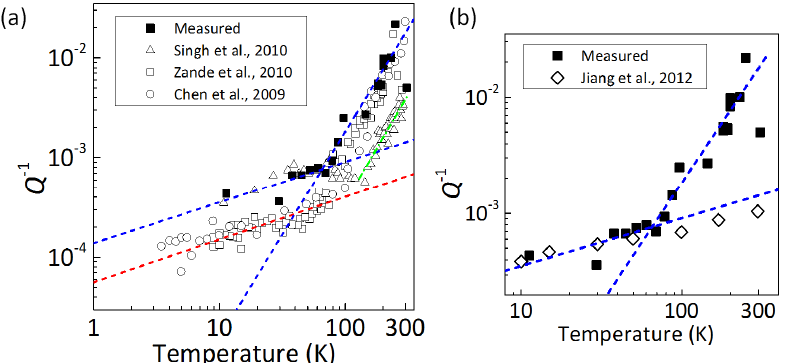
Figure 6. (Color online) ( a ) Temperature-dependent energy dissipation ( Q − 1 - T ) of doubly-clamped graphene resonators for our trilayer graphene resonators (solid squares) and monolayer graphene resonators in [2] (open circles), [3] (open squares) and [4] (open triangles). Blue dashed lines show linear fittings at different temperature ranges for our trilayer graphene resonators. The red dashed line indicates a linear fitting for monolayer graphene resonators in the lower temperature region. The green dashed line indicates a linear fitting for monolayer graphene resonators in [4] in the higher temperature region. ( b ) Comparison of Q − 1 - T curves between our doubly-clamped trilayer resonators and the molecular dynamics simulation result in [7] (open rhombuses). Reproduced from [12], with the permission of AIP